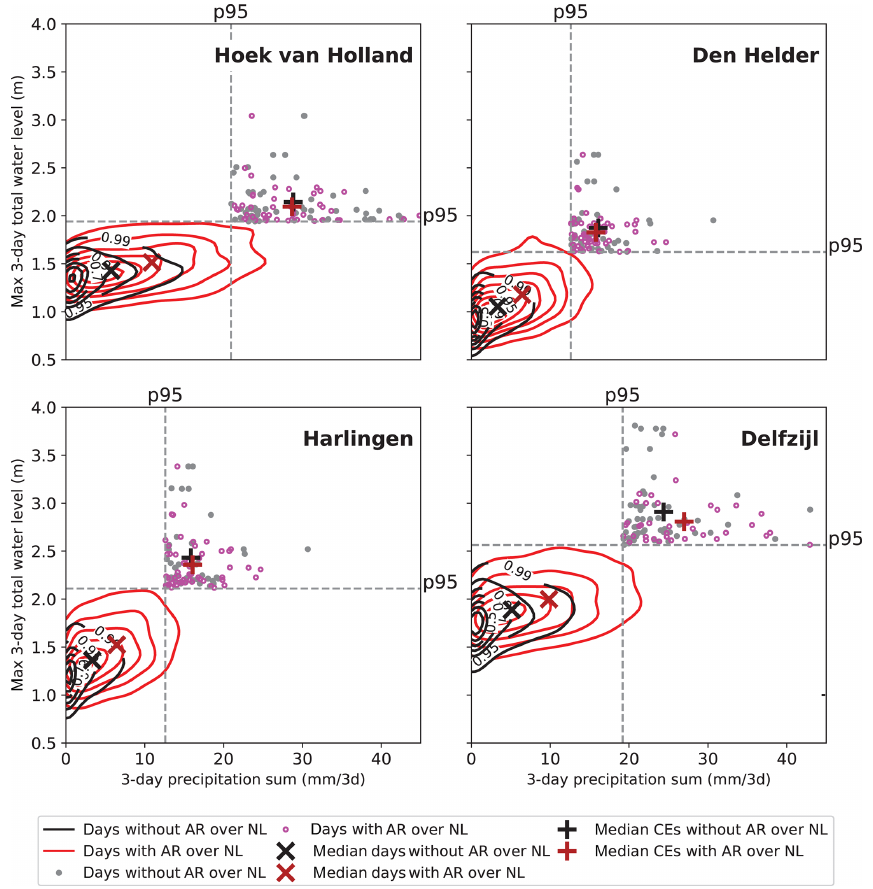
Figure 5. Joint probability distribution of 3-day precipitation sums (mm) and 3-day maximum total water level (m). Contours denote the area enclosing indicated percentage of data (30%, 50%, 70%, 90%, 95% and 99% contours are shown). Black (red) contours show data for days without (with) an AR over the Netherlands. Scatter plot in the in the upper right corner of each subfigure show total water level and precipitation pairs with values higher than the 95th percentile of both variables, i.e. compound events. Data points identified as compound events without an AR over the Netherlands are shown in black, those with an AR over the Netherlands are red. Crosses indicate the position of the mean of the full time series, while pluses show the median of the two variables only taking into account data from days with a CE. The colour coding for both markers is the same as for the